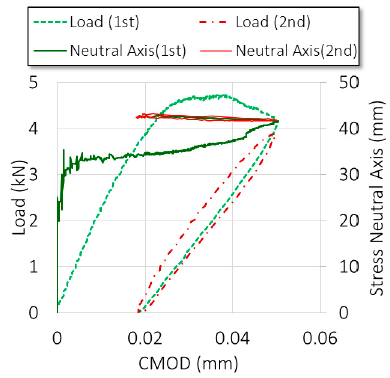
Figure 16. The behavior of the neutral axis with CMOD.